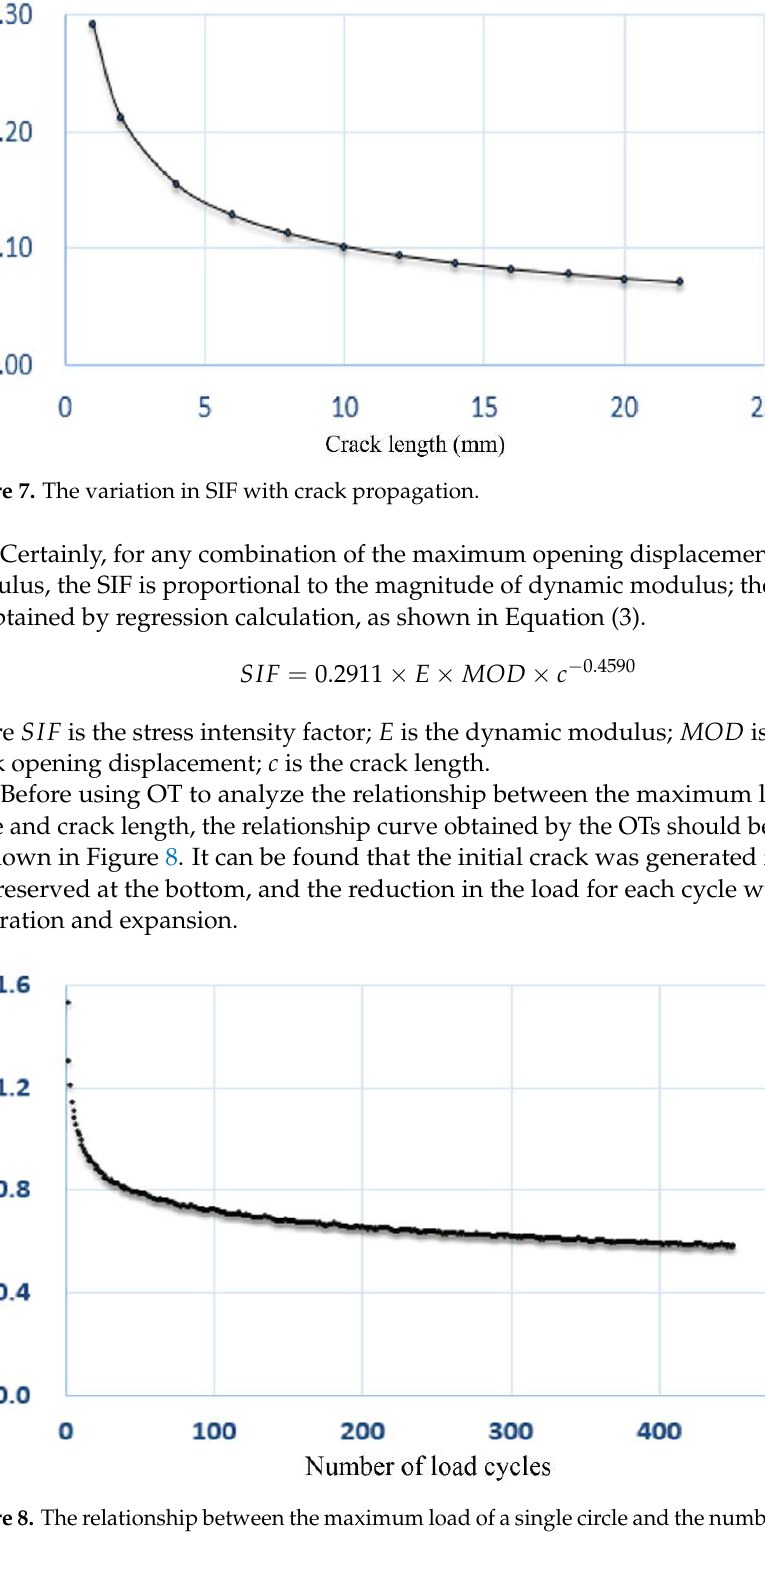
Figure 6. Numerical calculation model based on the OTs.